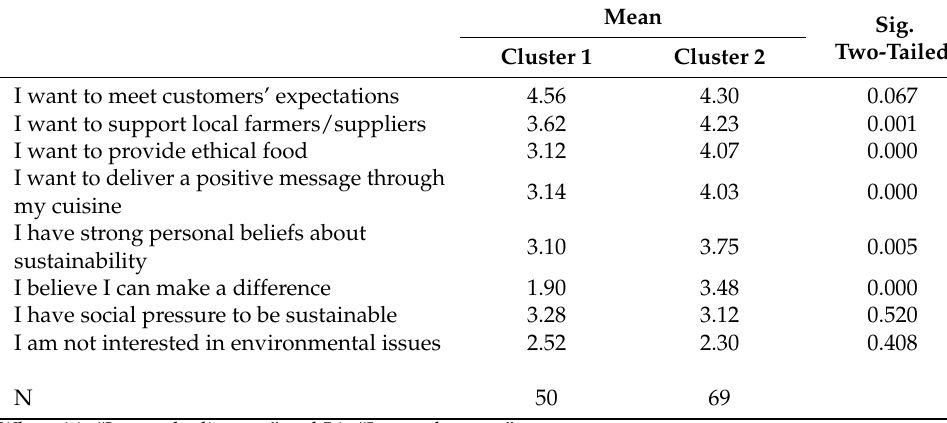
Table 4. Personal beliefs of the respondents.